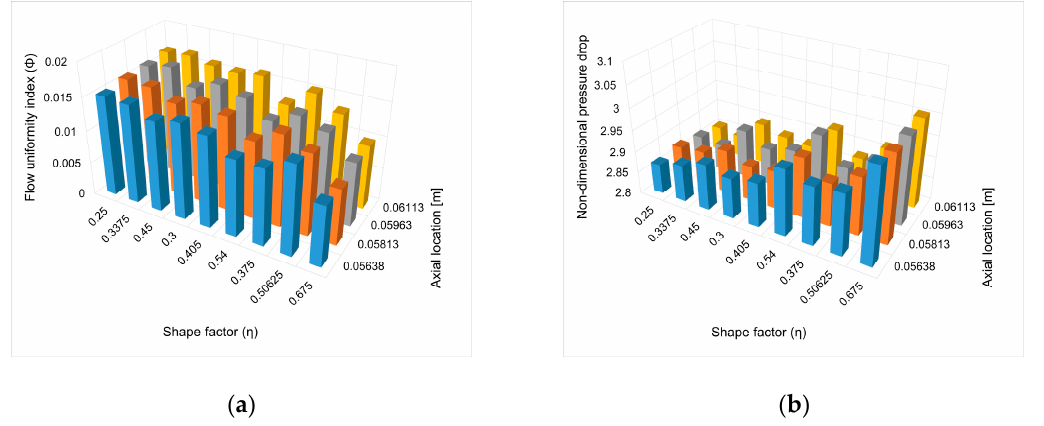
Figure 11. Correlation among parameters in novel U-type manifold design: ( a ) Flow uniformity index vs. shape factors and axial installation locations; ( b ) non-dimensional pressure drop vs. shape factors and axial installation locations.